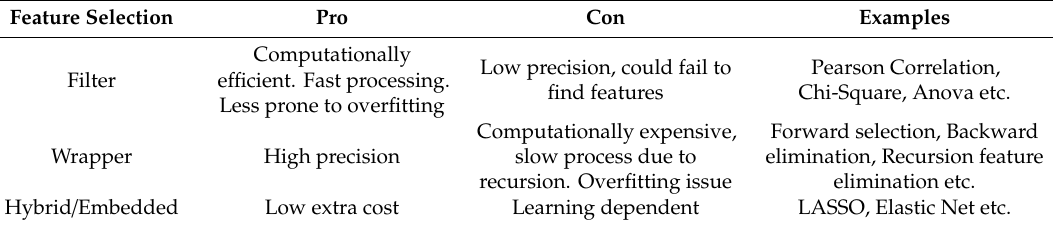
Table 1. Advantages and disadvantages of the feature selection